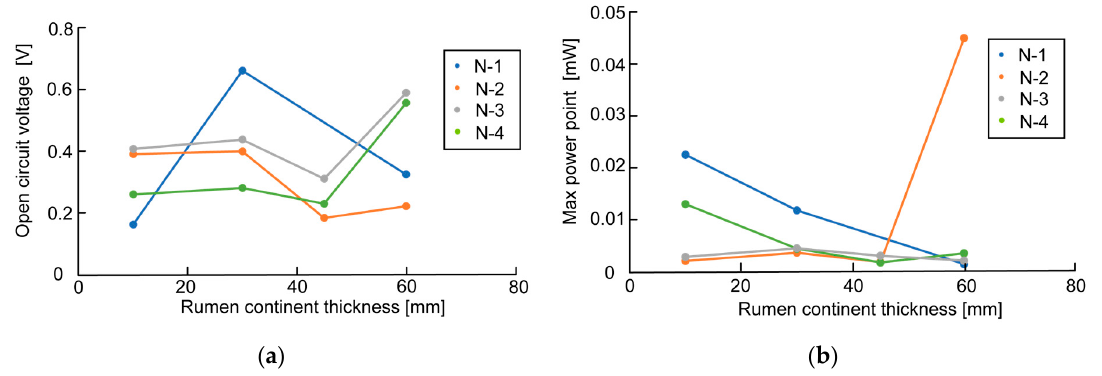
Figure 8. Measurement results of OCV and MPP in the experiment of changing rumen content thickness: ( a ) measurement result of OCV; ( b ) measurement result of